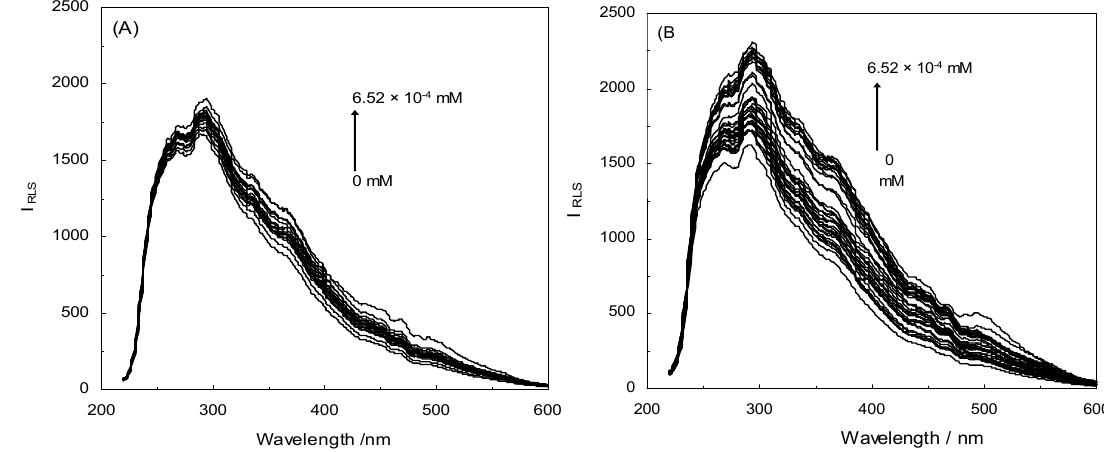
Figure 6. ( A ) The RLS spectra of HSA-NRF in the absence and presence of EMFs. The concentration of HSA was 4.5 × 10 − 3 mM and the NRF concentration was increased from (0 to 6.52 × 10 − 4 ) mM. T = 298 K; pH 7.40. The HSA-NRF system in the absence of an EMF; ( B ) HSA-NRF in the presence of an EMF (100 Hz/2.4 mT); ( C ) the curves of ∆ I versus NRF in the absence and presence of EMFs for HSA-NRF( □ ), 100 Hz/2.4mT( ◊ ), 100 Hz/6.4 mT( ∆ ), 1 KHz/0.98 mT( (cid:31) ), 1 KHz/1.9 mT( (cid:31) ), 10 KHz/0.17 mT(-), 10 KHz/63 μ T(_), 100 KHz/39 μ T( ○ ), 1 MHz/59 μ T